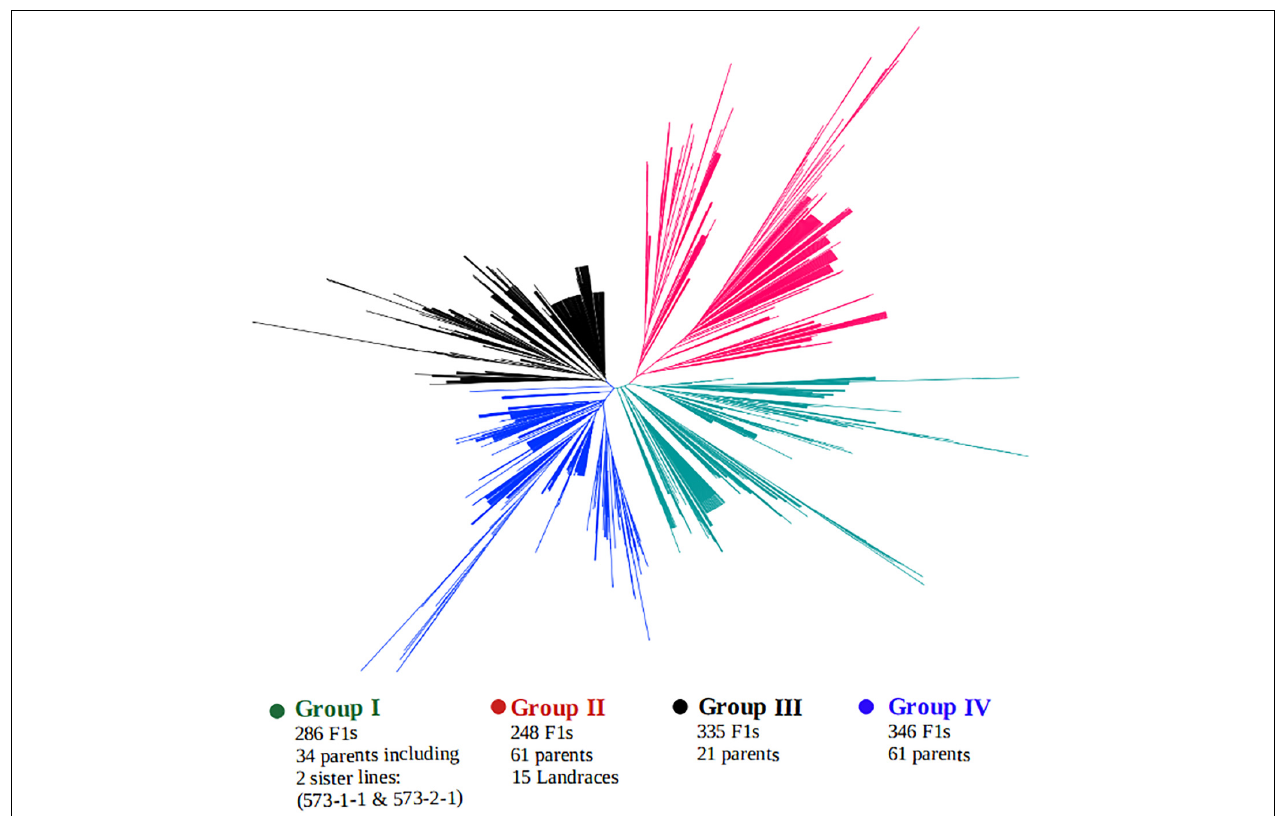
FIGURE 5 | Clustering of F 1 hybrids and the parents using 17 KASP-based single nucleotide polymorphism (SNP) markers. Four sub-groups were formed with parents distributed across all the groups. Group II contained the local varieties while Group I harbored the two male parents IT99K-573-1-1 and IT99K-573-2-1.